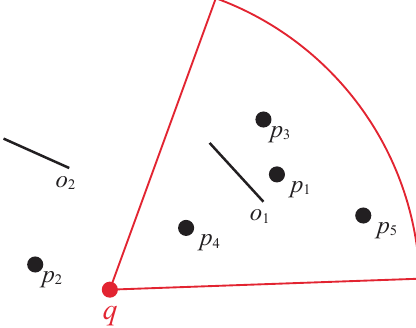
Figure 10. Example of V 2- kNN ( q ) , where k =